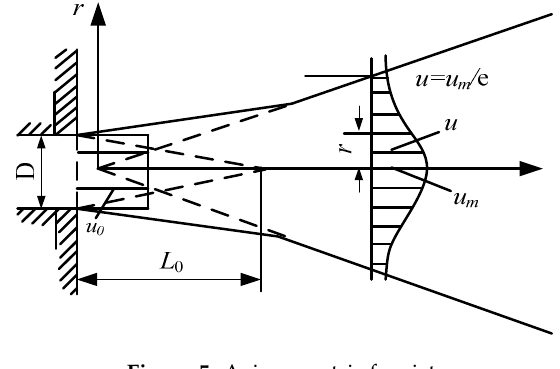
Figure 5. Axisymmetric free jet.